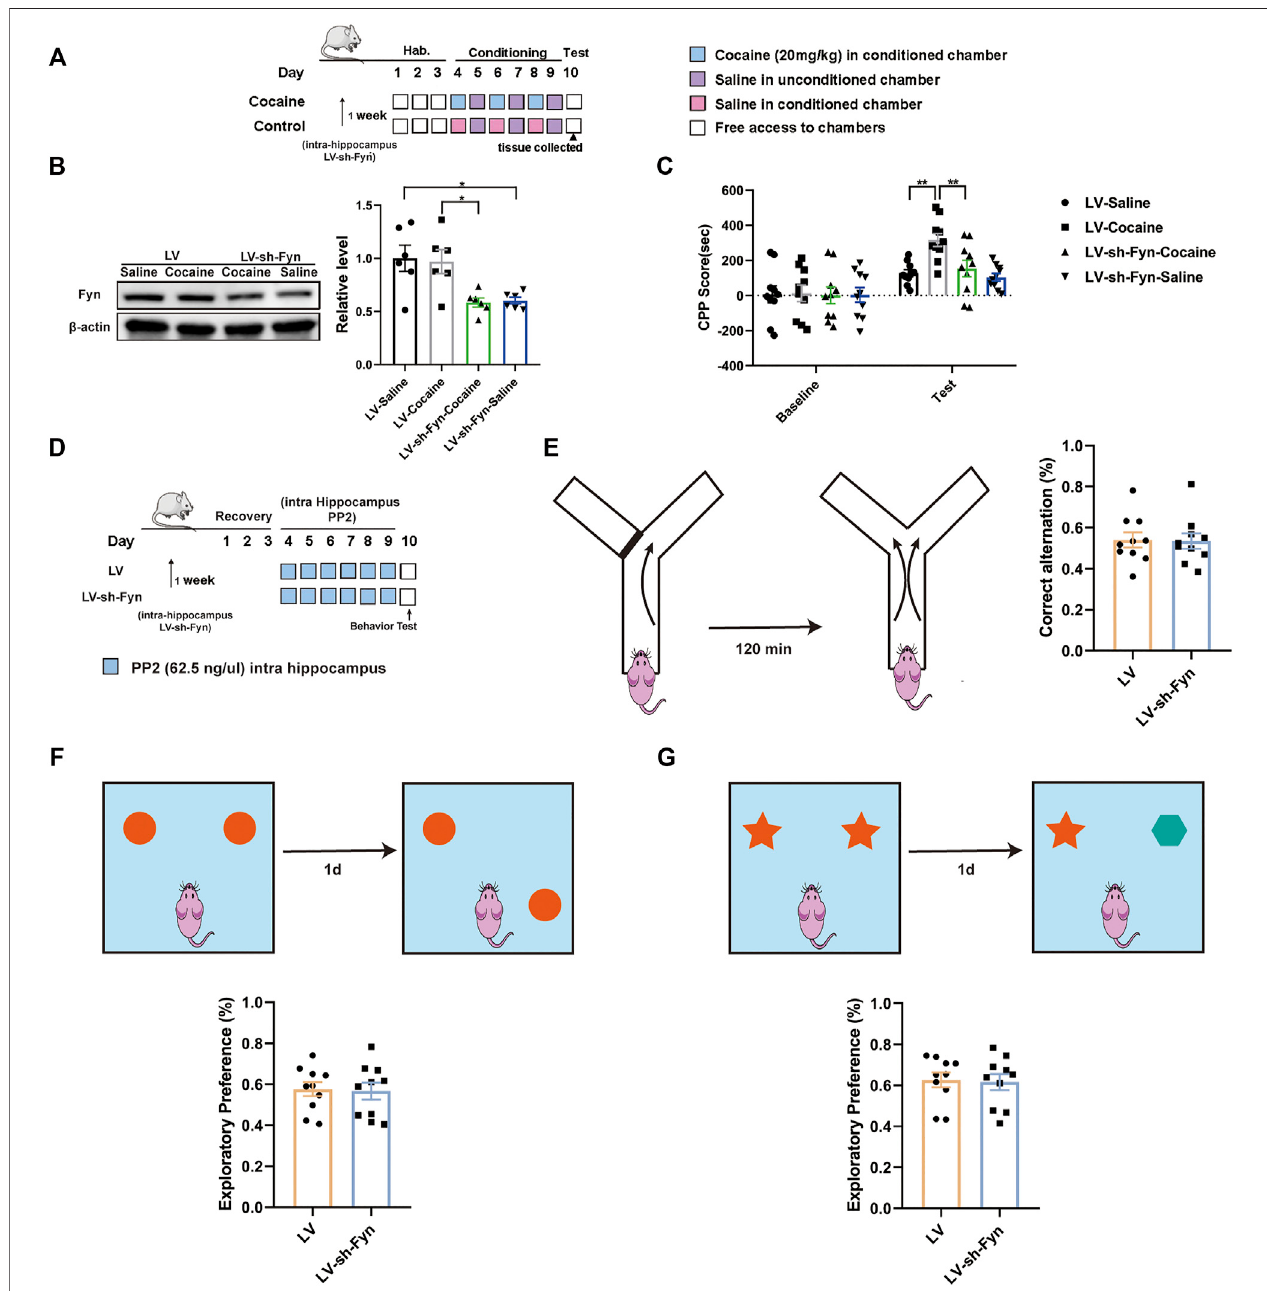
FIGURE 6 | Knock-down PP2 in the hippocampus reduced the cocaine CPP score. (A) Experimental timeline for LV-mediated Fyn knock-down in hippocampus 1 weekbeforecocaineCPPtest. (B) ImmunoblottingofFyninthehippocampusafterLV-mediatedFynknock-down ( n =6per group). (C) Knock-down Fynsigni fi cantly attenuatedthecocaineCPP score( n =10per group). (D) ExperimentaltimelineforPP2injectioninFynknock-downmice. (E) Therewasnosigni fi cantdifference across groupsintheY-mazetestafterPP2injectionofFynknock-downmice( n =10pergroup). (F,G) Fyn-knockdownmicefailedtoexhibitingexploratorypreferencesin the novel object position test and novel object recognition test after PP2 administration ( n = 9 per group). Data are the means ± SEM, * p < 0.05 and ** p < 0.01. Hab, habituation.